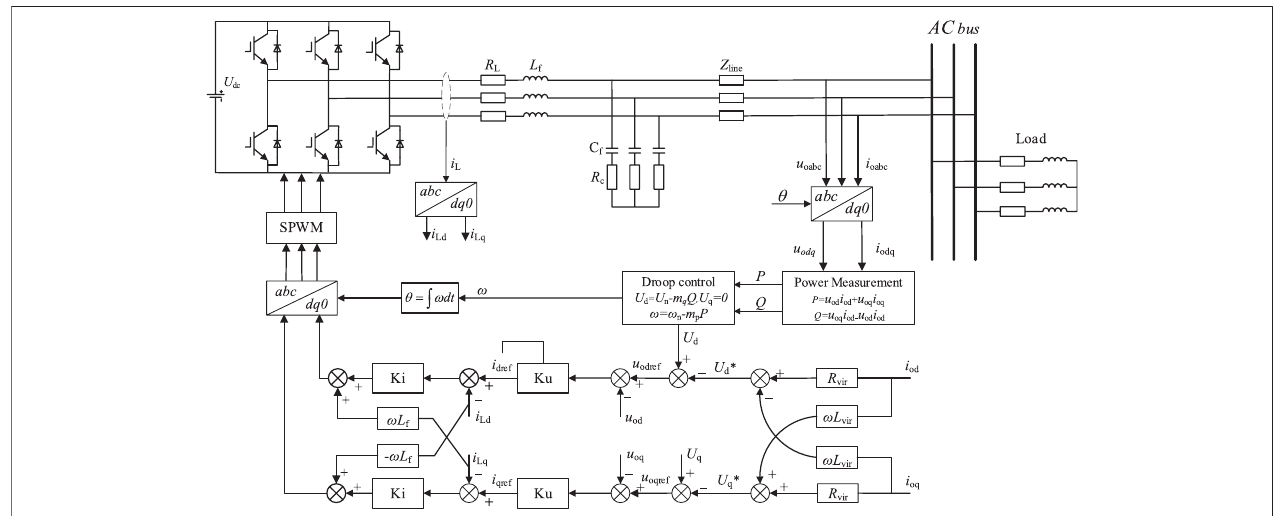
FIGURE 2 | Traditional inverter topology of the island microgrid.